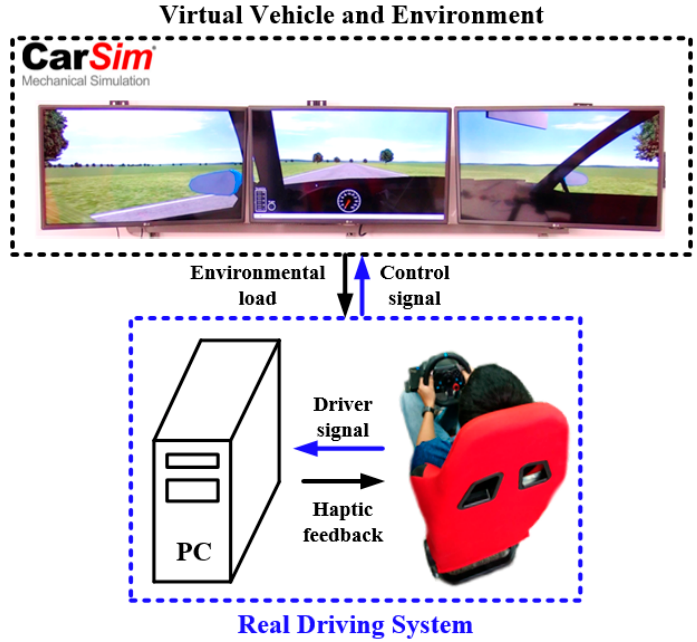
Figure 1. Schematic graph of the driving simulator system.